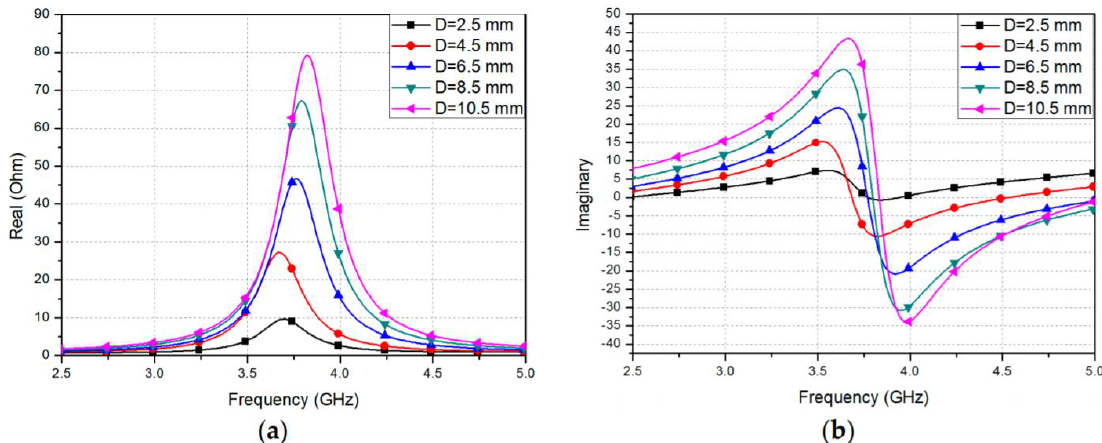
Figure 18. Simulated input impedance with D at different locations: ( a ) real part; and ( b ) imaginary part of impedance [78].